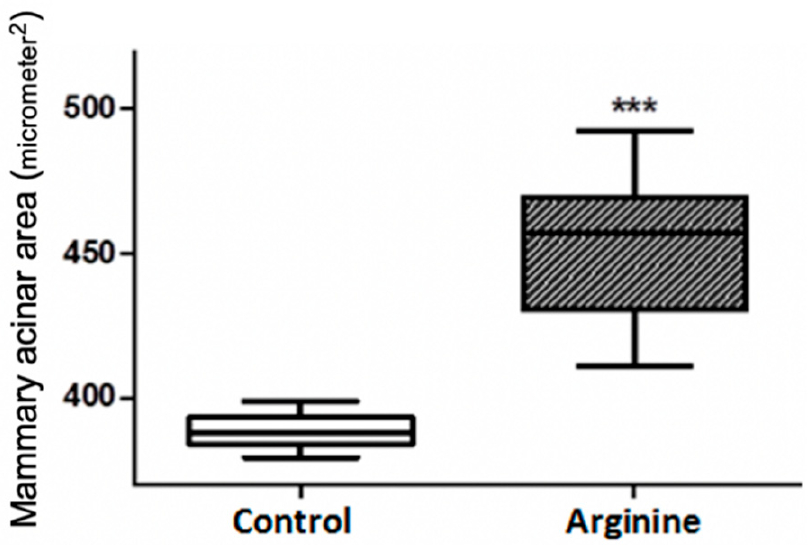
Figure 2. Comparison of mammary acinar area (um 2 ) *** Represents p < 0.001.